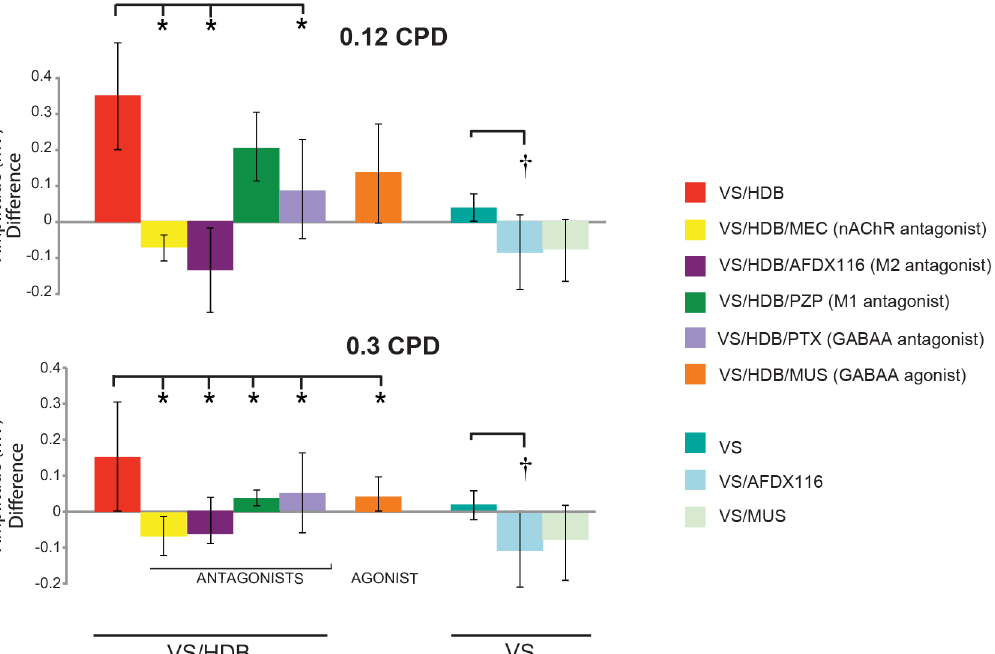
Fig 3. Change in VEP amplitudes following pharmacological modulation during visual/cholinergic stimulation (VS/HDB). The histograms represent the VEP difference of amplitude (Post-Pre training) for the different groups for the trained spatial frequency of 0.12 CPD (A) and 0.3 CPD (B). Note that the VEP amplitude enhancement following the visual/cholinergic training was blocked by MEC, AFDX, or PTX injection. ( * ; one-way ANOVA, post-hoc Dunnett, p < 0.05, compared to VS/HDB group, † ; post-hoc Dunnett, p < 0.05, compared to VS group). The error bars represent the average deviation. (Abbreviations; PZP: pirenzepine; MEC: mecamylamine; AFDX: AF-DX 116; MUS: muscimol and PTX: picrotoxin).